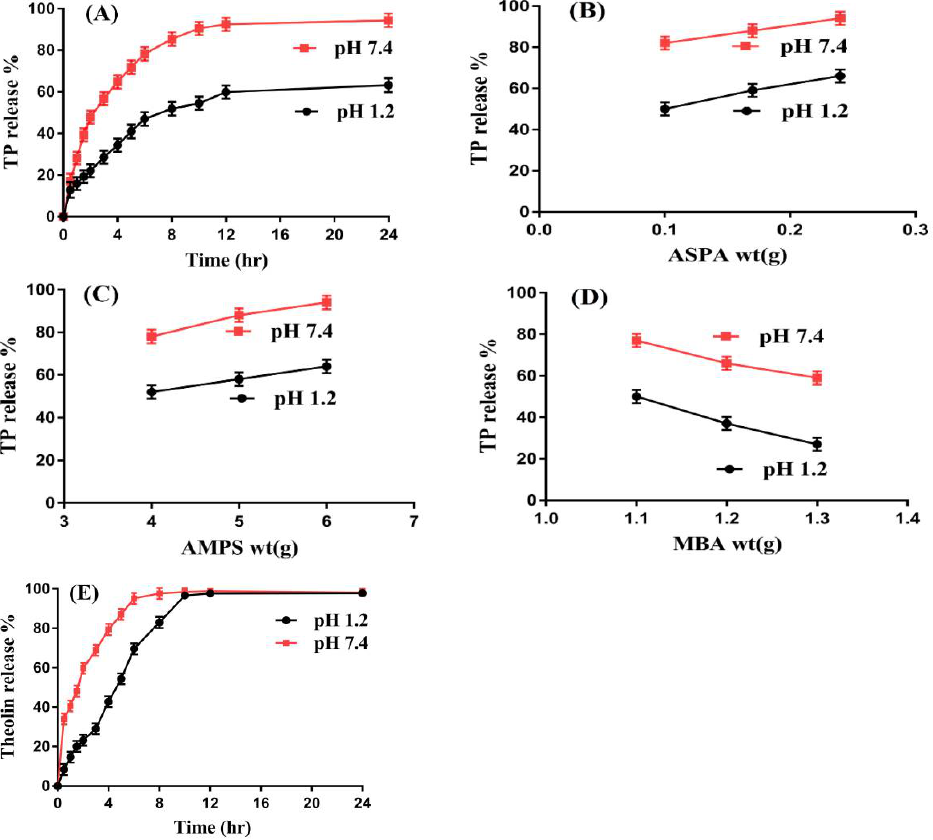
Figure 3. Effect of ( A ) pH, ( B ) ASPA, ( C ) AMPS, and ( D ) MBA on TP percentage release from ASPA-pAMPS microgels, ( E ) effect of pH on drug release from Theolin tablet.